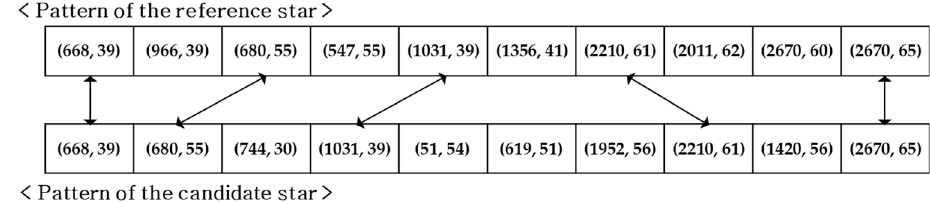
Figure 6. Example of scoring in the voting procedures with 10 singular value grid patterns.